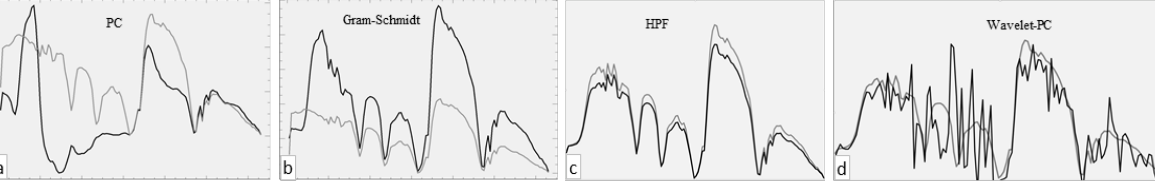
Figure 11. Quality control using spectral profile of a selected pixel of building area. Grey line is from original image and black lines are from (a) PC, (b) Gram-Schmidt, (c) HPF and (d) wavelet-PC sharpened